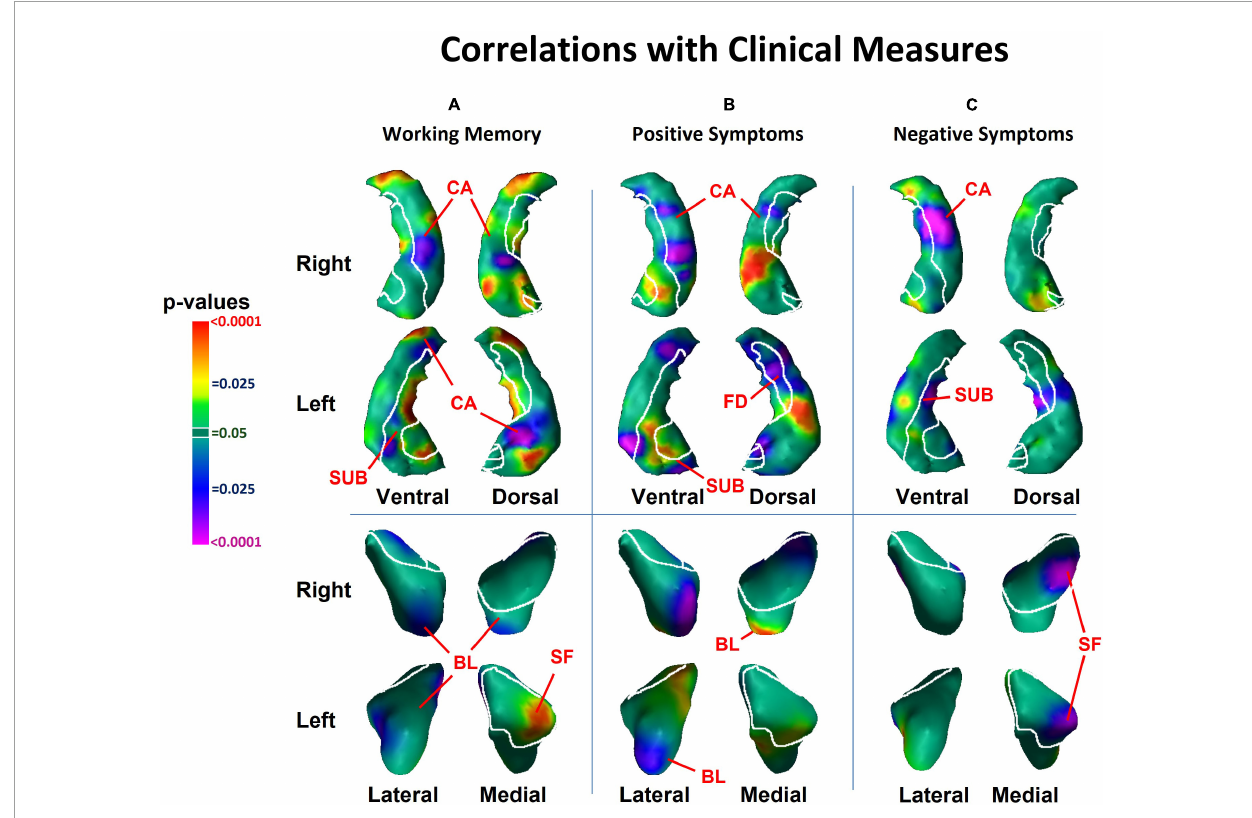
FIGURE2 Associations with surface morphology of the hippocampus and amygdala for clinical measures of (A) working memory performance, (B) positive psychosis symptom severity, and (C) negative psychosis symptom severity. Here, working memory scores are inverted so that higher scores indicate greater deficits in working memory. Higher values of positive and negative symptoms indicate greater clinical symptoms. The cytoarchitectonic map overlies the structures. CA, cornu ammonis; FD, fascia dentata; SUB, subiculum; SF, superficial nucleus; CM, centromedial nucleus; BL, basolateral